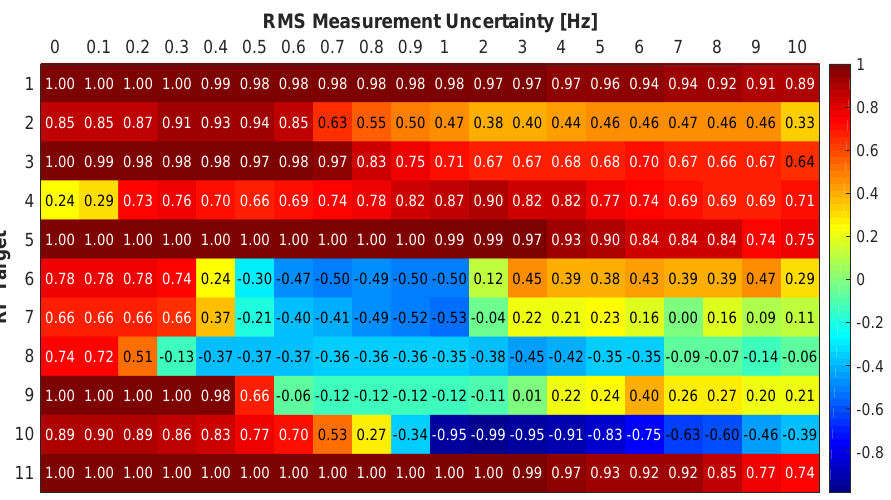
Figure 20. Confidence ratio for matching specific cellular emanation measured by the constellation of RF receivers with the corresponding target from the multi-spectral video tracker using the RMSD